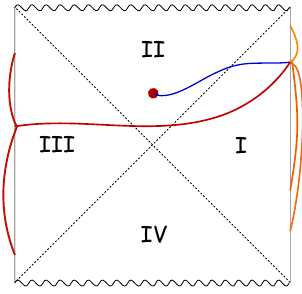
Figure 3: Expression for the gauge-invariant bulk scalar ˆ φ (blue line) in terms of the smeared dressed right operators (orange lines) and right-framed left operators (red lines). The left contributions can be decomposed into a dressed operator contribution and a boundary-to- boundary Wilson